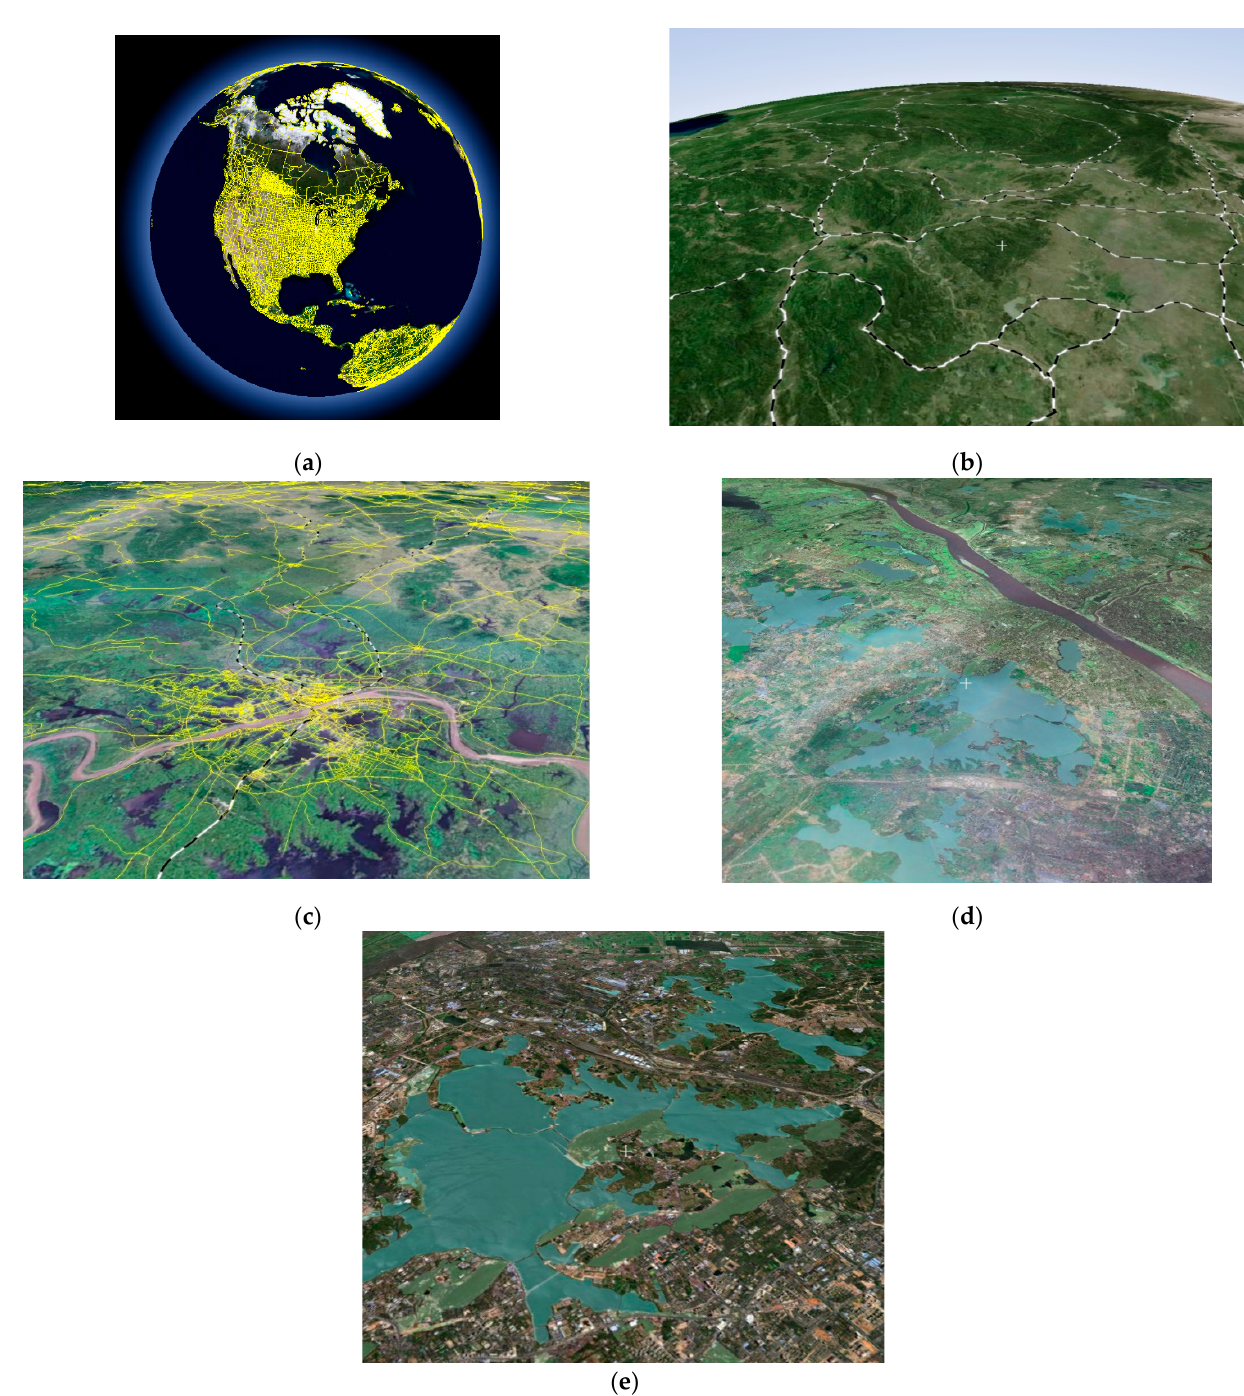
Figure 7. Visualization of vector tiles on a 3D terrain surface. ( a ) global administrative map onto a global 3D terrain surface. ( b ) global rail data. ( c ) a texture-based method for the global rail data, and a geometry-based method for global roads. ( d ) visualization of the Wuhan lakes. ( e ) visualization of the woods polygon in 3D